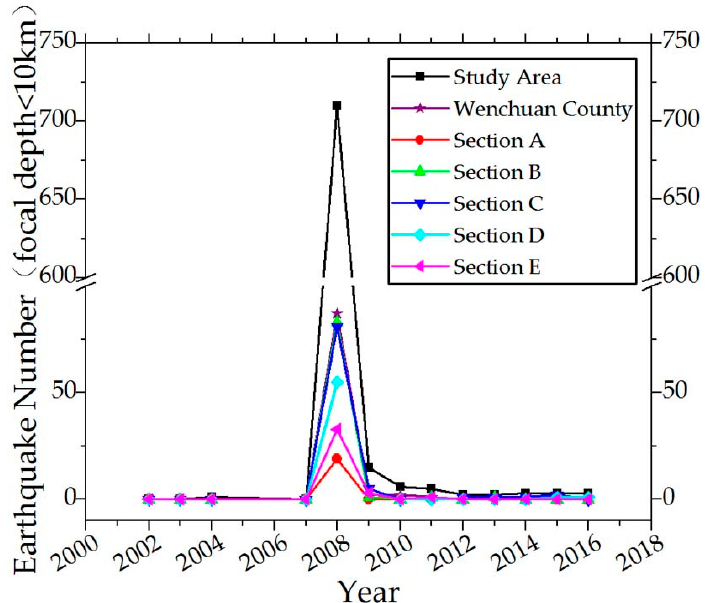
Figure 12. Time series of the number of earthquakes (depth < 10 km) in the study area from 2002 to 2016 (source: USGS).